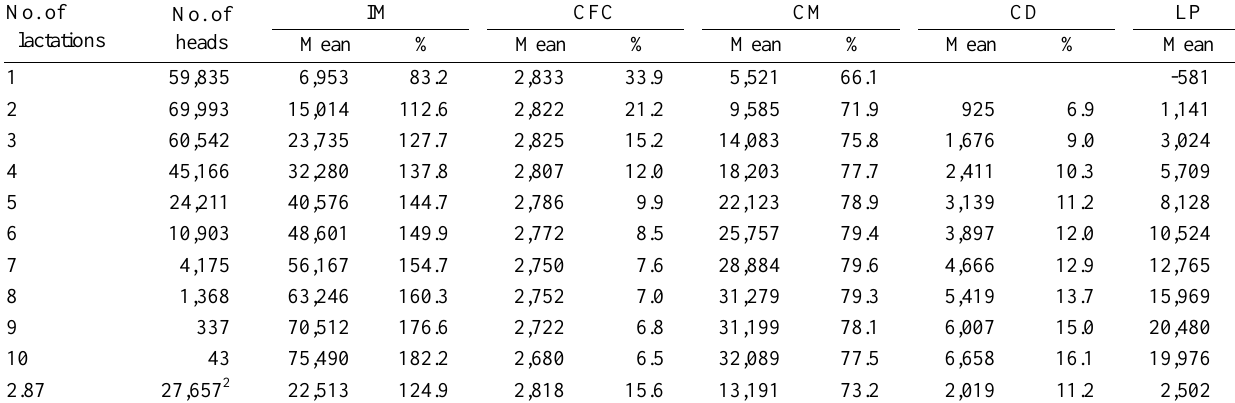
Table 2. Mean economic values 1 of production cost, milk income and lifetime profit according to number of lactations and percentage from total production cost for lifetime No. of